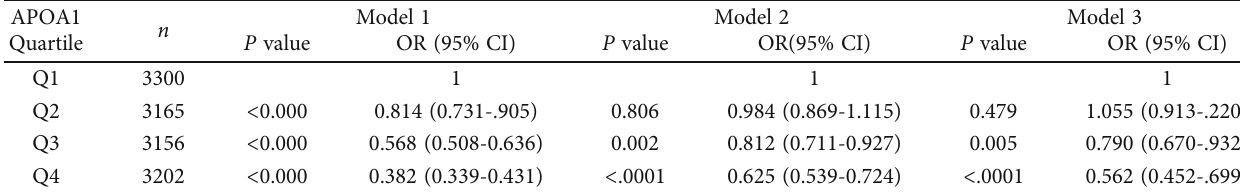
Table 2: MLR results of risk factors of NAFLD according to serum APOA1 quintiles.